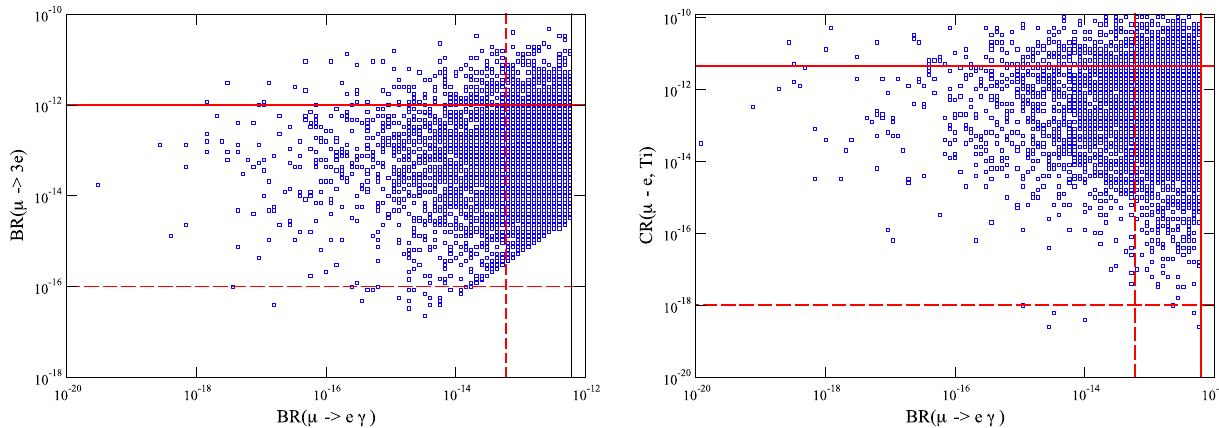
Fig. 8 Left: the correlation between μ → e γ and μ → 3 e for our sample of viable models. Right: the correlation between μ → e γ and μ – e conversion in